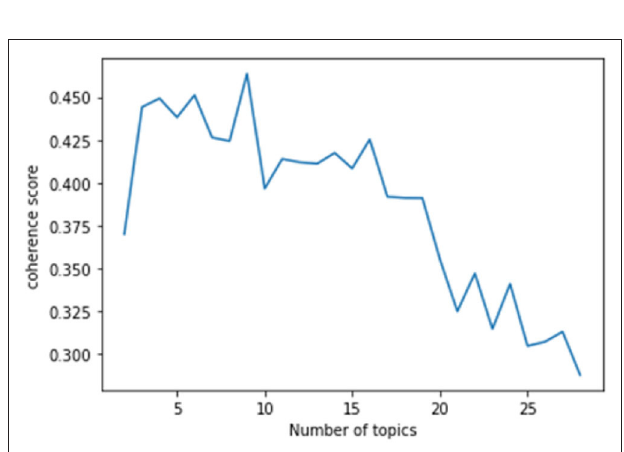
FIGURE 4 | Estimated coherence scores (after the COVID-19